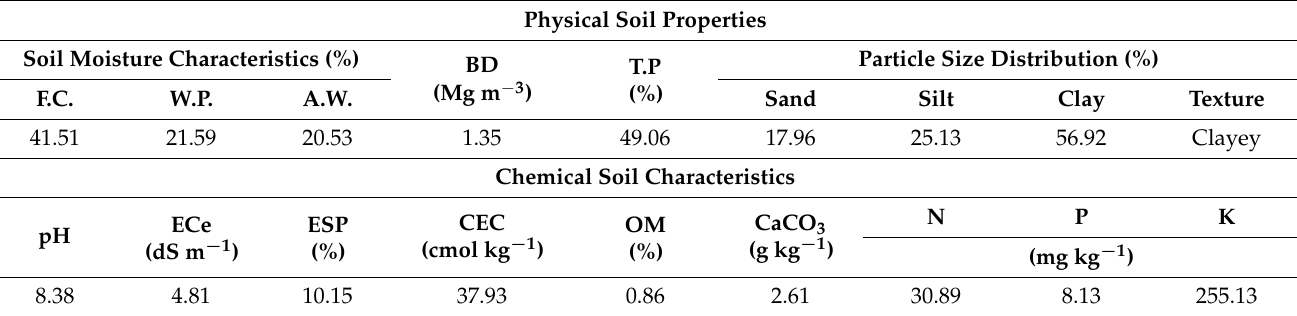
Table 1. Soil physical , chemical, and moisture properties before sowing.